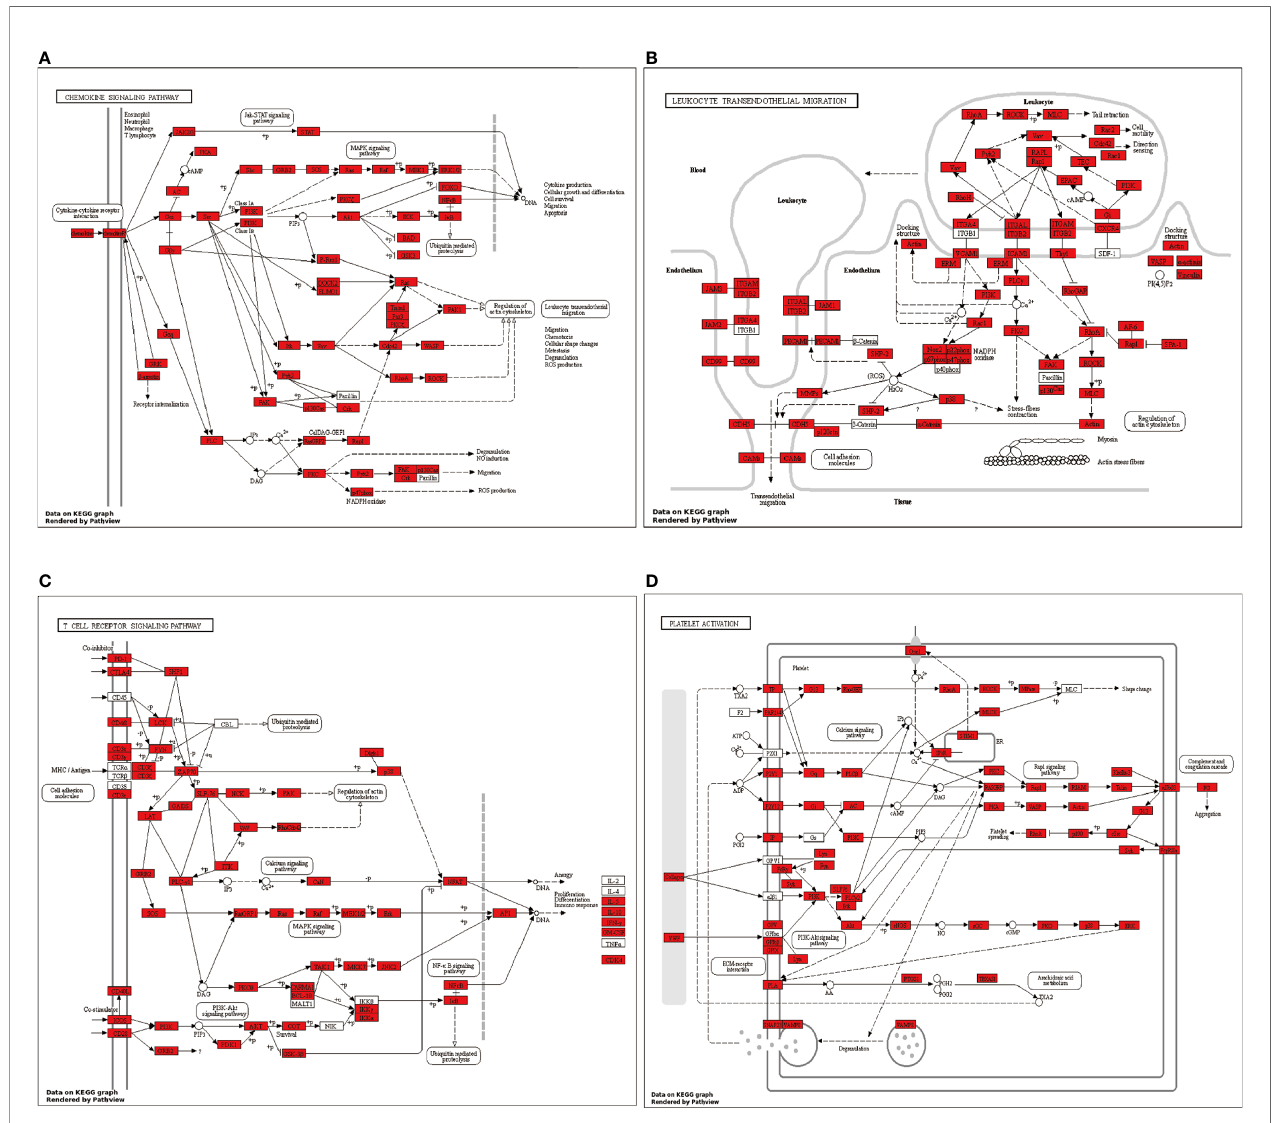
FIGURE 7 | Putative (A) chemokine signaling pathway, (B) platelet activation pathway, (C) T cell receptor signaling pathway, and (D) leukocyte transendothelial migration pathway were constructed based on KEGG mapping. Red squares indicate proteins identi fi ed as differentially expressed miRNAs; white circles indicate miRNAs not identi fi ed as differentially expressed in our